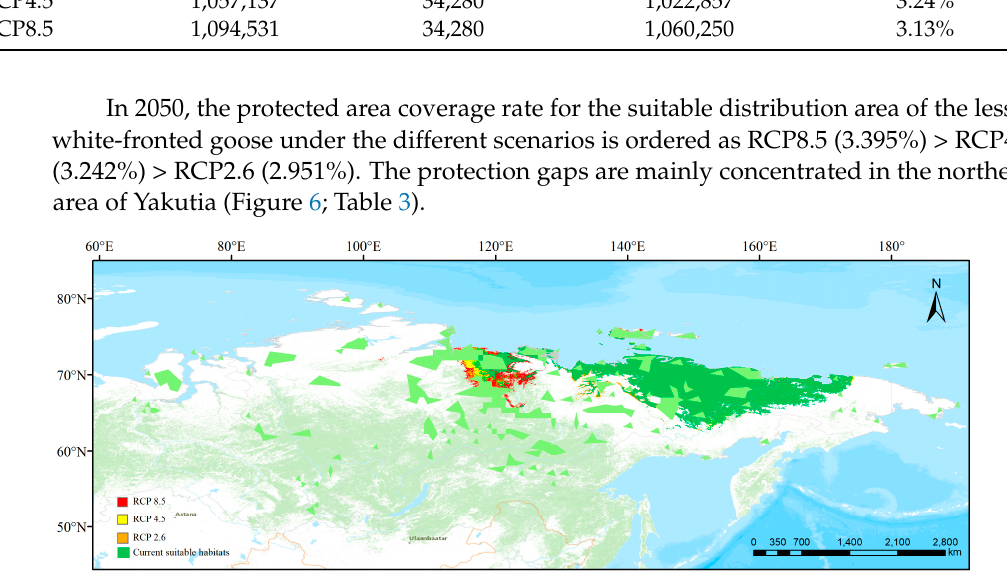
Figure 6. Conservation gaps under different climate scenarios in 2050: red indicates the protection gaps in the case of RCP2.6; yellow represents the protection gaps in the case of RCP4.5; and orange represents the protection gaps in the case of